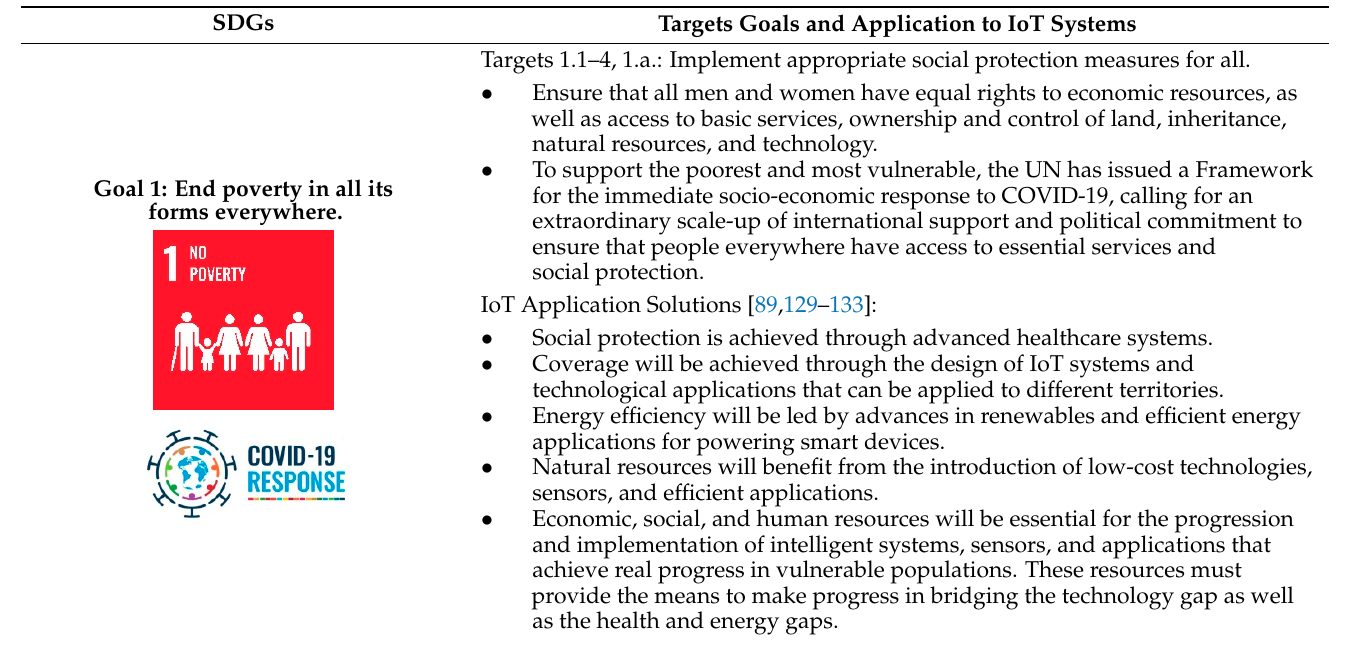
Table 5. Impact of the Sustainable Development Goals on IoT applications for improving health and the environment. SDGs Targets Goals and Application to IoT Systems